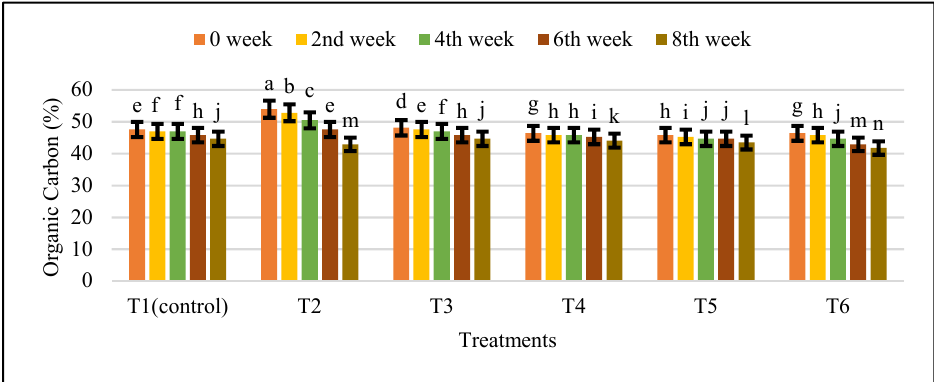
Figure 11. The effects of different treatments of IONPs on organic carbon content during anaerobic. digestion of cattle manure. Bars with different letters depict significantly different values at p ≤ 0.05. Table 2. Effect of different treatments of IONPs on total solids and volatile solid degradation during eight weeks of batch digestion.